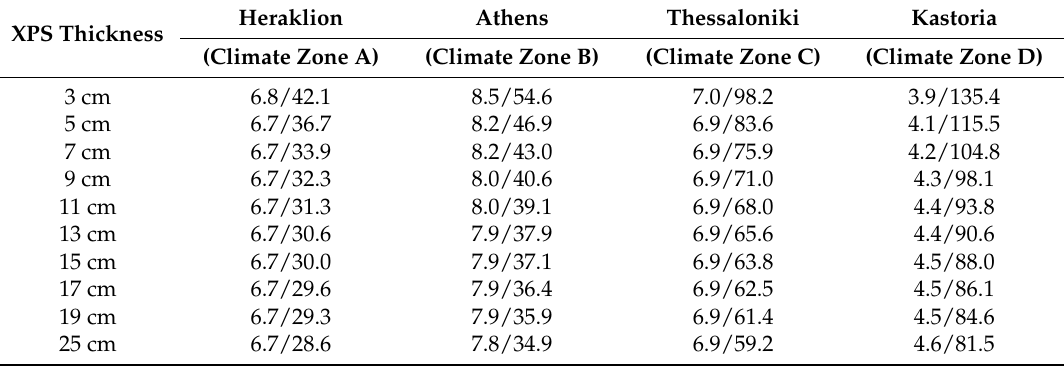
Table 4. Final energy consumption in electricity/heating oil of the reference building (in KWh/m 2 ) 1 . XPS